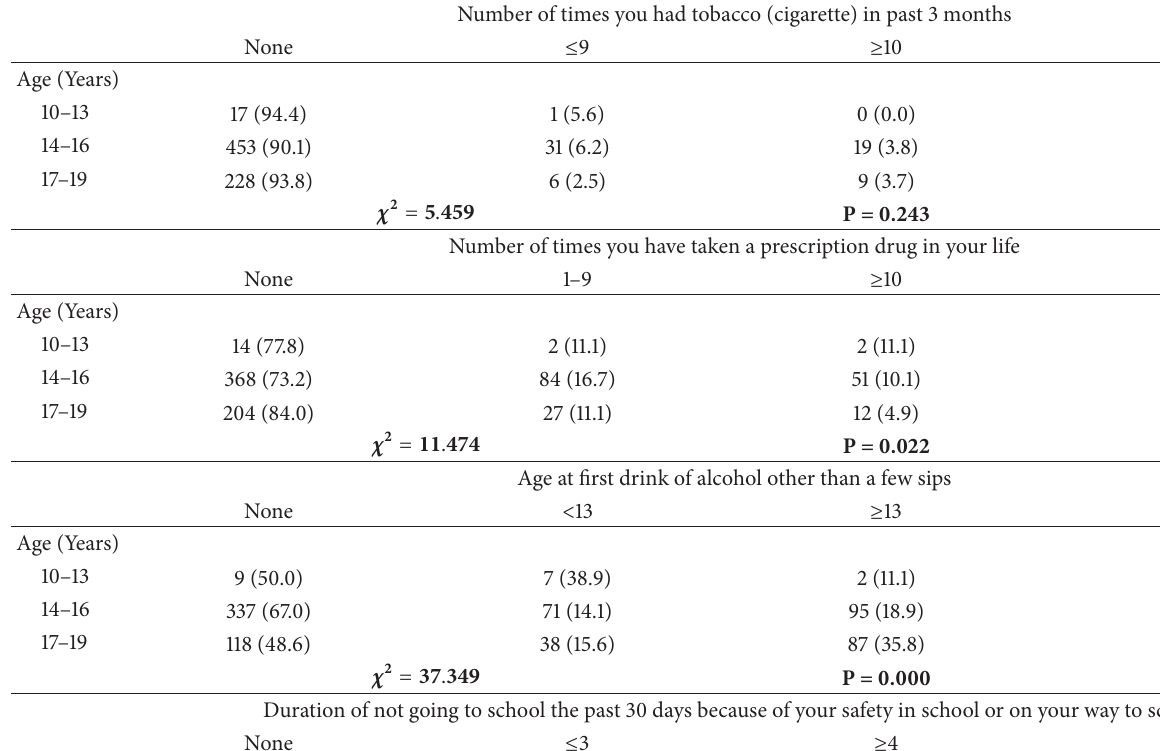
Table 3: Associations of age in categories with adolescent